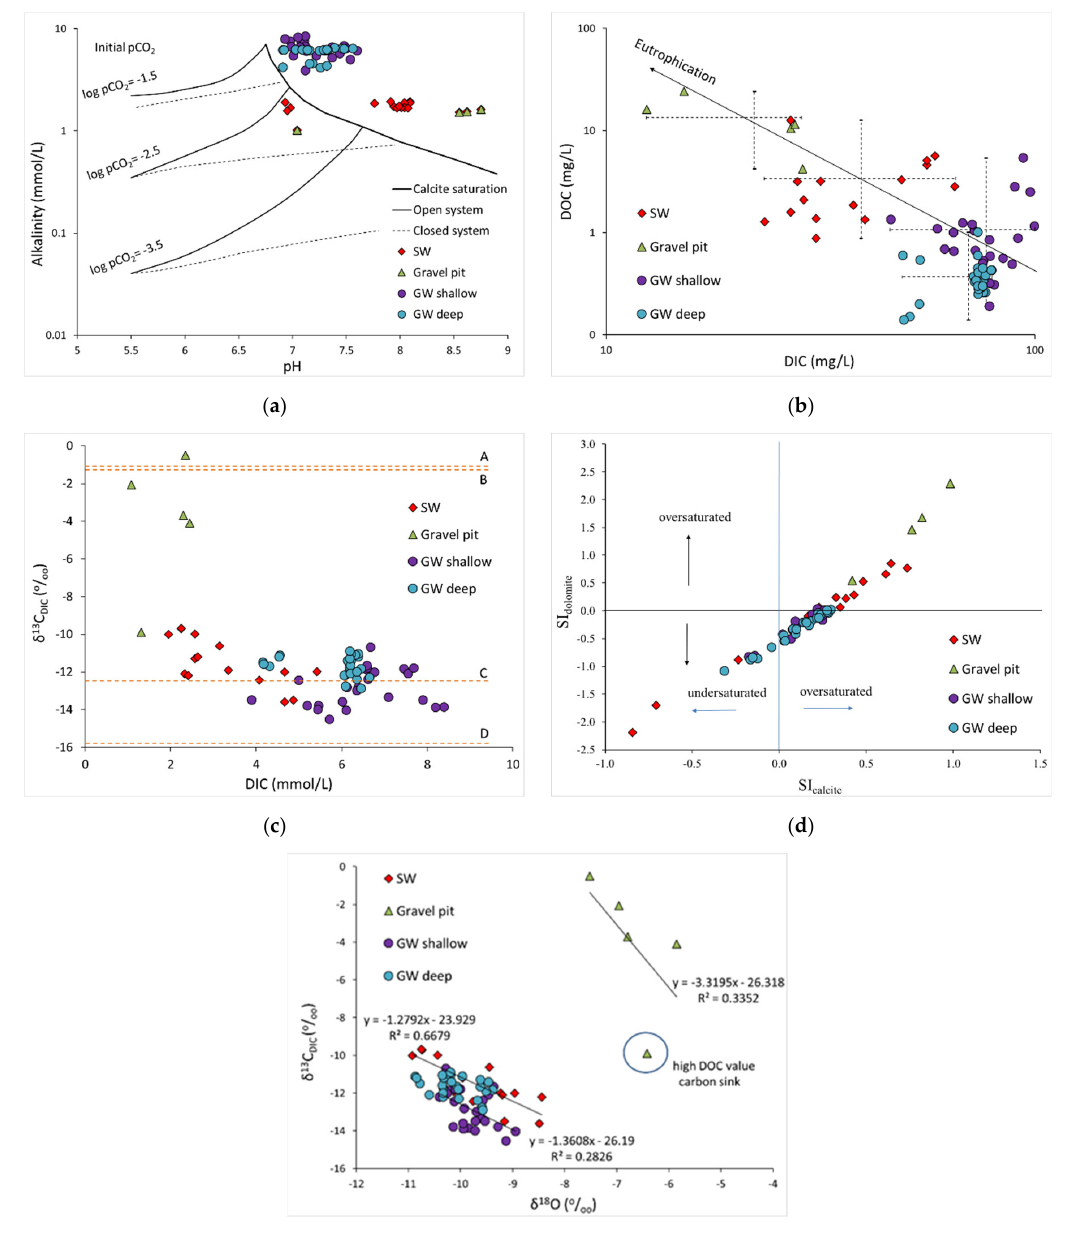
Figure 6. Plots of selected chemical and isotopic parameters: ( a ) Variation of alkalinity vs. pH; ( b ) DOC vs. DIC; ( c ) Variation in the δ 13 C DIC vs. DIC in the groundwater–surface water aquifer system. Orange dashed lines represent fractionation lines: (A) Open system DIC equilibration with the atmosphere with an average value of − 1.2‰; (B) Dissolution of carbonate with δ 13 C carb of − 0.1‰, providing the δ 13 C DIC of − 1.1‰; (C) Open system equilibration of DIC with soil CO 2 originating from degradation of organic matter with δ 13 C CO2 of − 24.4‰; (D) Nonequilibrium carbonate dissolution with δ 13 C CO2 of − 24.4‰; ( d ) relationship between saturation indices of calcite and dolomite; ( e ) relationship between δ 18 O of groundwater and δ 13 C DIC .